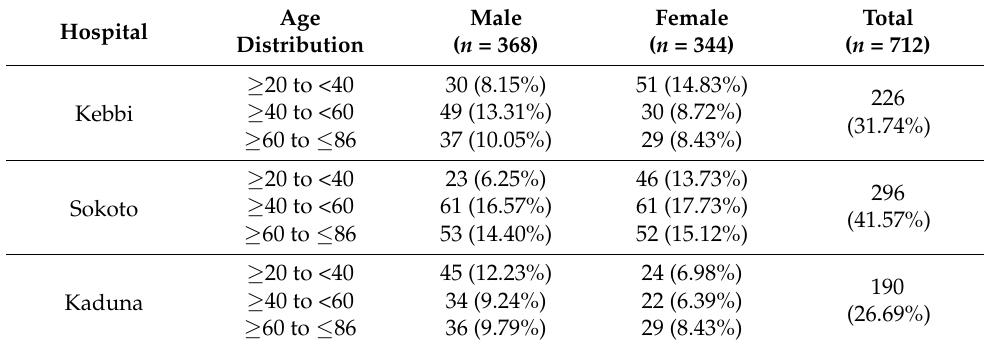
Table 1. Distribution by age of the current study